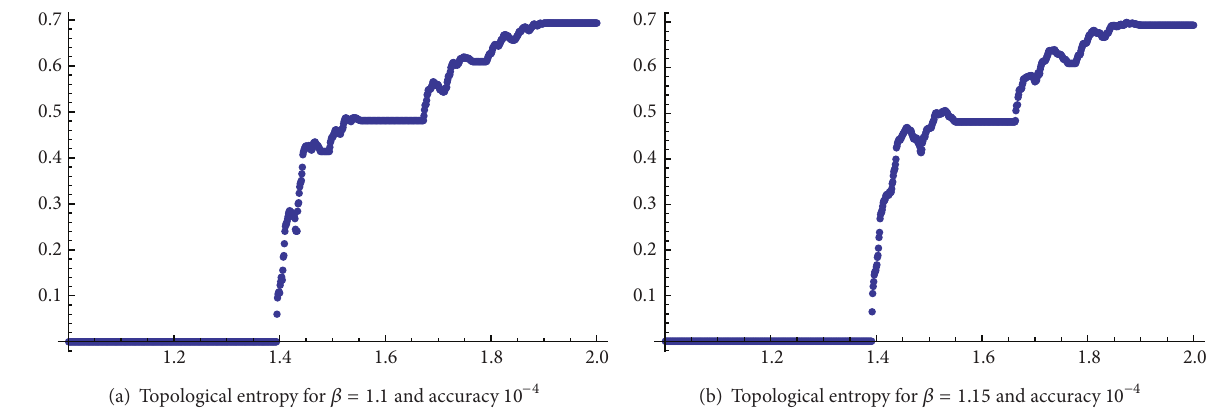
(b) Topological entropy for 𝛽 = 1.15 and accuracy 10 −4